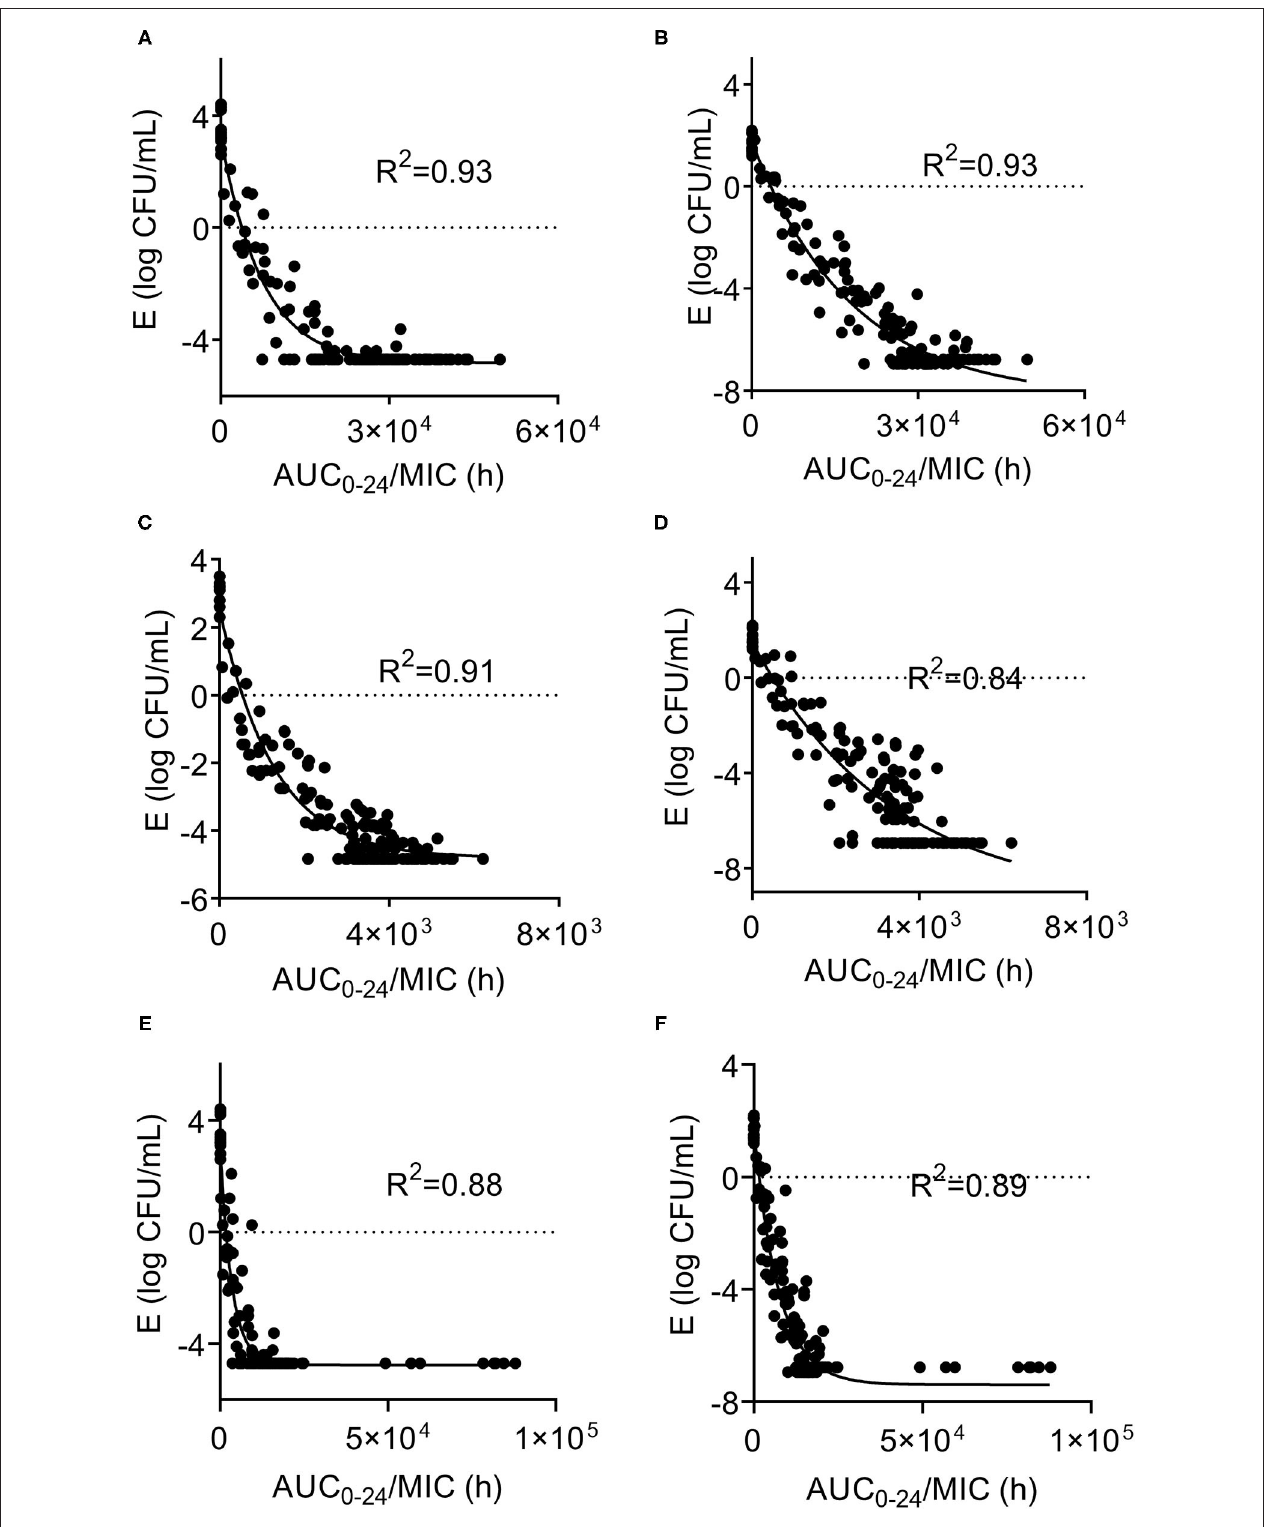
FIGURE 4 | Sigmoid E max relationships between ex vivo antibacterial effect and PK/PD indexes of cefquinome against S. aureus ATCC29213, B4048RH-31.4, 2014RQG-33.15. (A,B) Showed Sigmoid E max relationships against S. aureus ATCC29213 with an initial bacterial load of10 6 and 10 8 log10CFU/mL. (C,D) showed Sigmoid E max relationships against S. aureus B4048RH-31.4 with an initial bacterial load of 10 6 log 10 CFU/mL and 10 8 log 10 CFU/mL. (E,F) Showed Sigmoid E max relationships against S. aureus 2014RQG-33.15 with an initial bacterial load of 10 6 log 10 CFU/mL and 10 8 log 10 CFU/mL.